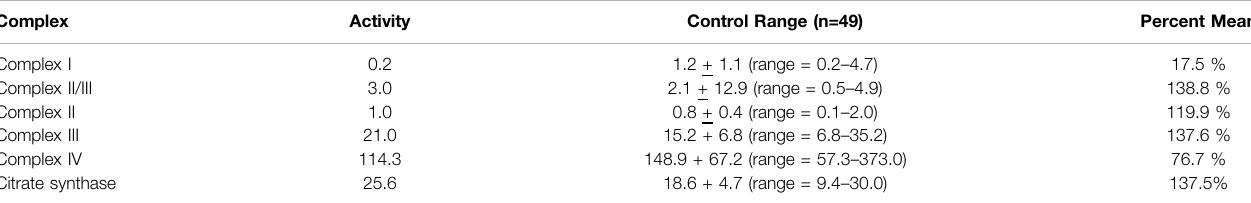
TABLE 2| Spectrophotometry analysis ofelectron transport chainenzymeactivity from muscle biopsy material. These results are from the muscle biopsy ofthe patient with CYP2U1 gene variants. Complex